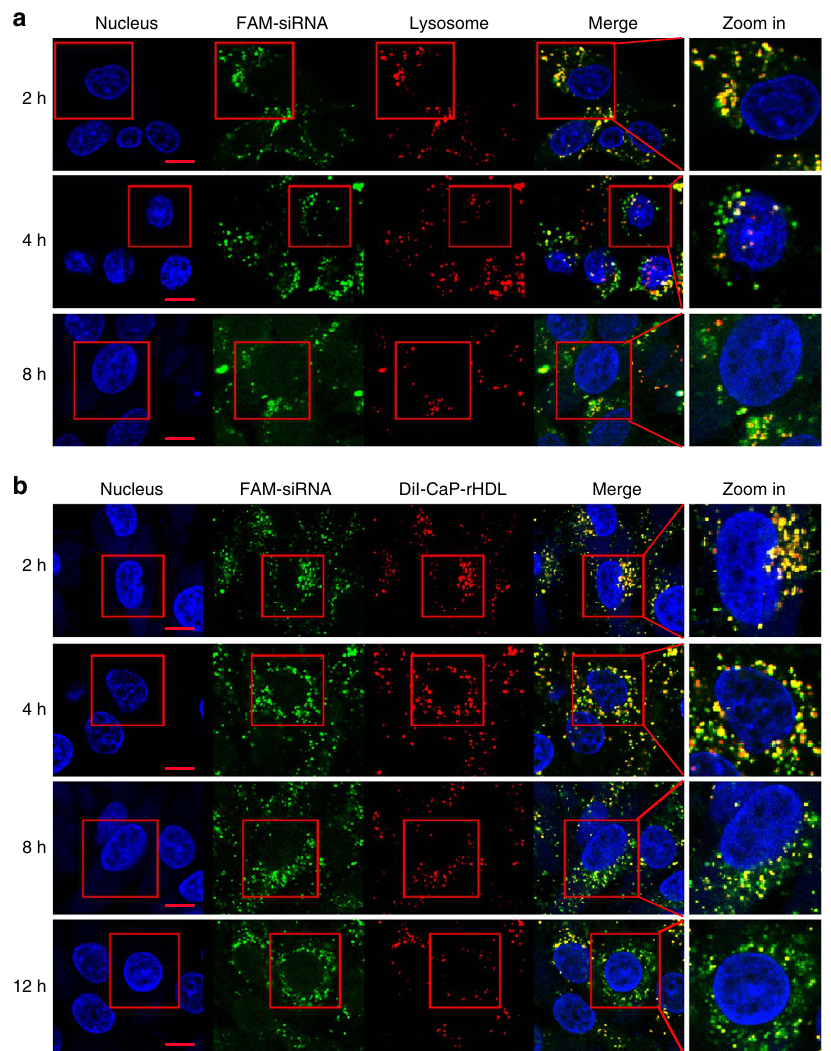
Figure 7 | CaP-rHDL-mediated efficient delivery of siRNA in C6 glioblastoma cells. ( a ) Lysosome escape of FAM-siRNA (green) loaded by CaP-rHDL after incubation for 2, 4 and 8h at the siRNA concentration of 100nM in C6 glioblastoma cells. Lysosome was indicated by LysoTracker Red. Nucleus was stained by Hoechst33342 (blue). ( b ) Dissociation of FAM-siRNA (green) from its carrier CaP-rHDL after incubation for 2, 4, 8 and 12h at the siRNA concentration of 100nM in C6 glioblastoma cells. DiI (red) was inserted in the lipid membrane of CaP-rHDL as the fluorescent probe. Nucleus was stained by Hoechst33342 (Blue). Scale bar: 10 m